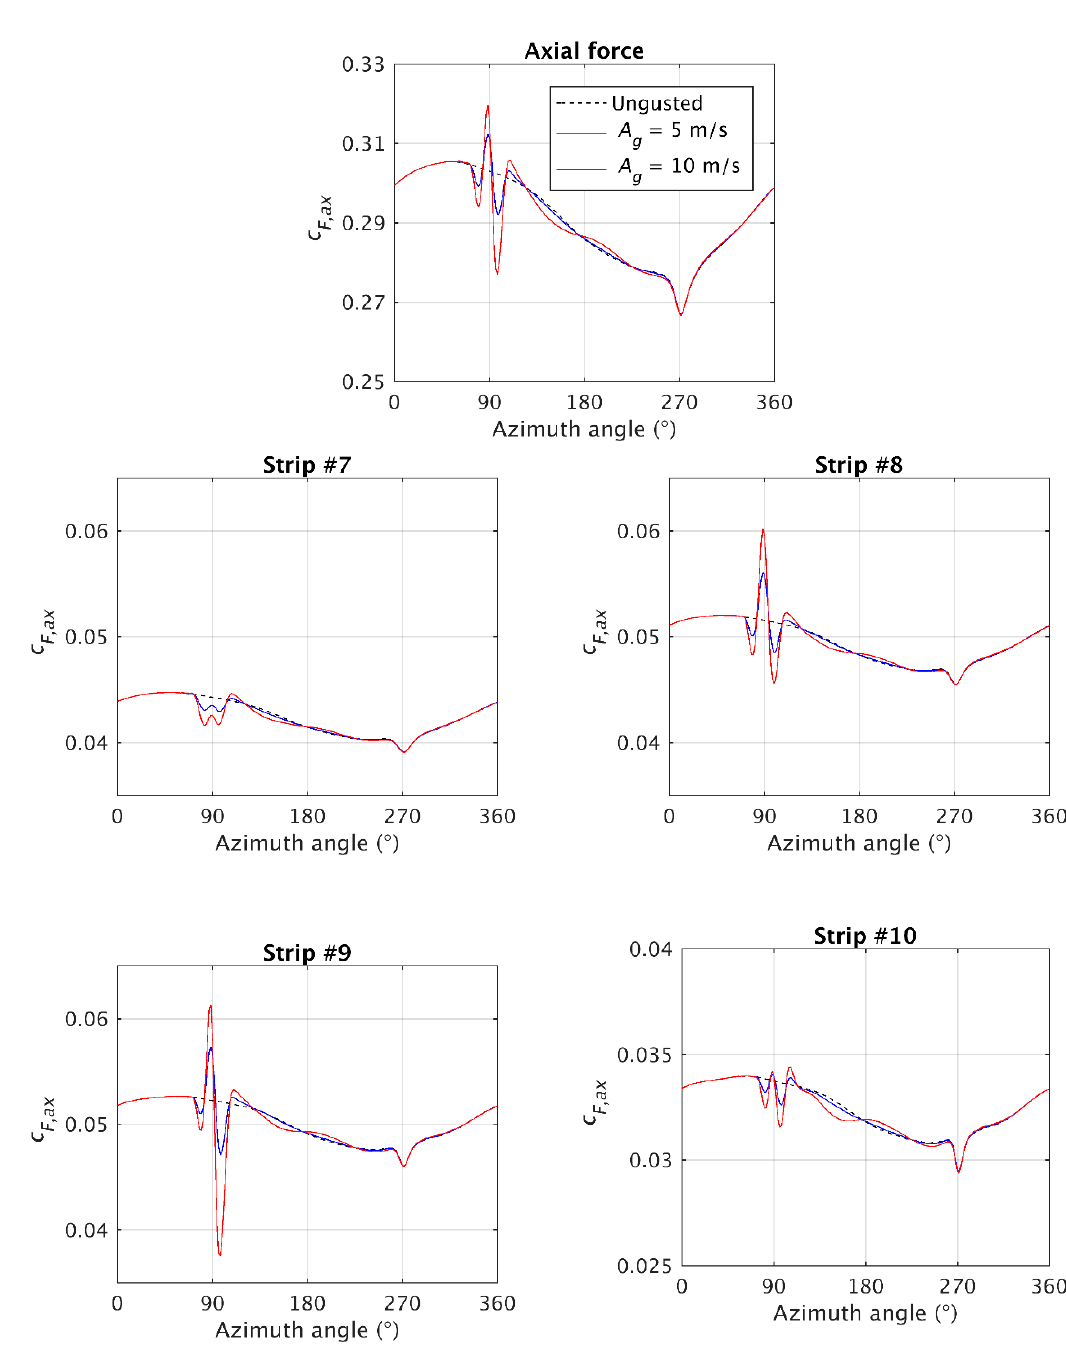
Figure 8. Zero net flow rate gusts: ( top ) total aerodynamic axial force over the blade hit by the gust as a function of its azimuth angle and ( bottom ) axial force contribution of the 4 most outboard strips.